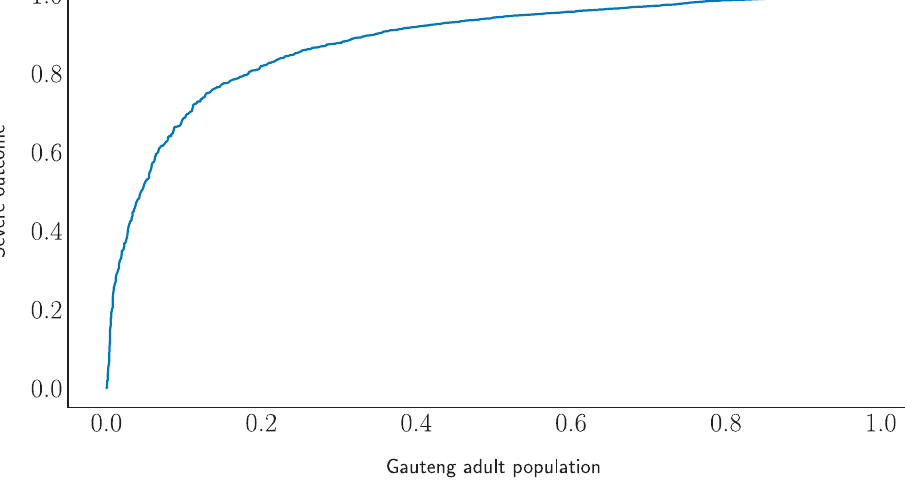
Figure 1. The receiver operating characteristic curve of the DNN model (see text).